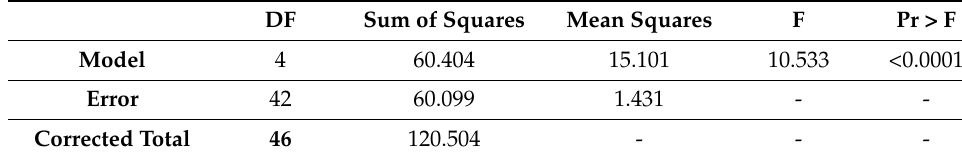
Figure 1. Cortisol concentration in manehair samples belonging to the 3 groups. Results are shown as mean ± standard deviation. Table 3. ANCOVA results and significance.